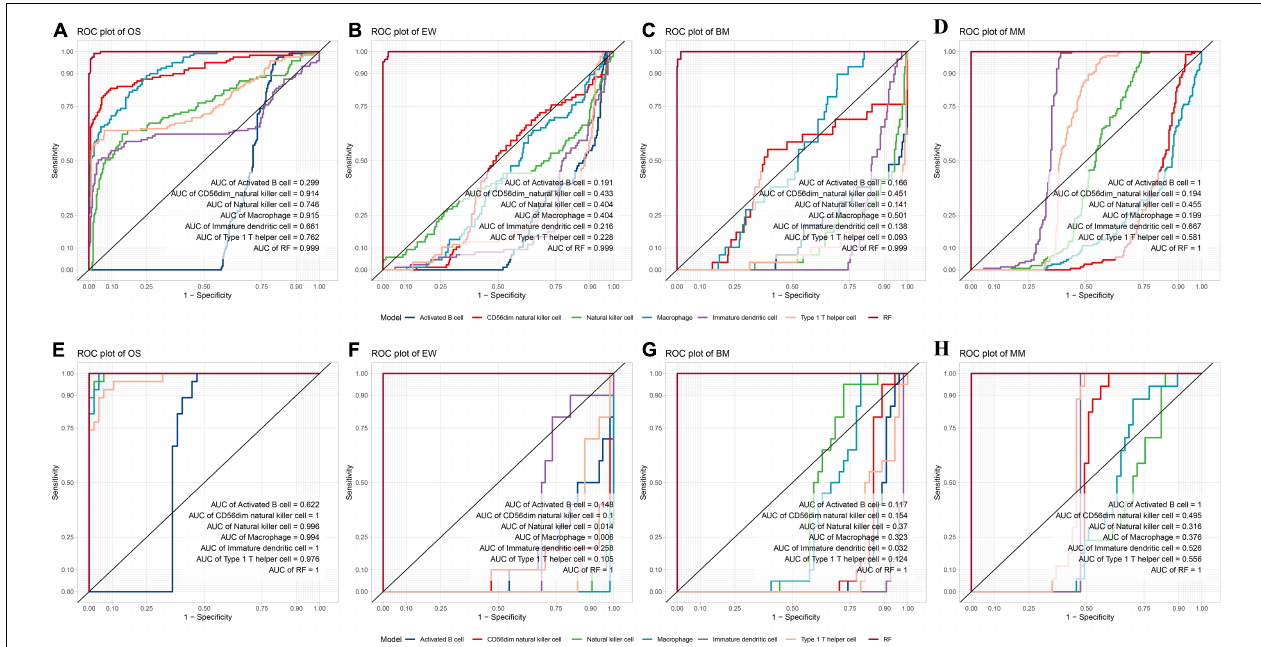
FIGURE 4 | Internal and external validation of the diagnostic model. (A–D) ROC plot of the Random forest model compared with a single variable diagnostic model per disease in the test dataset. (E–H) ROC plot of the random forest model compared with a single variable diagnostic model per disease in the validation dataset. ROC, receiver operating characteristic; MM, multiple myeloma; EW, Ewing’s sarcoma; BM, prostate cancer bone metastases; OS, osteosarcoma; RF, the random forest diagnostic